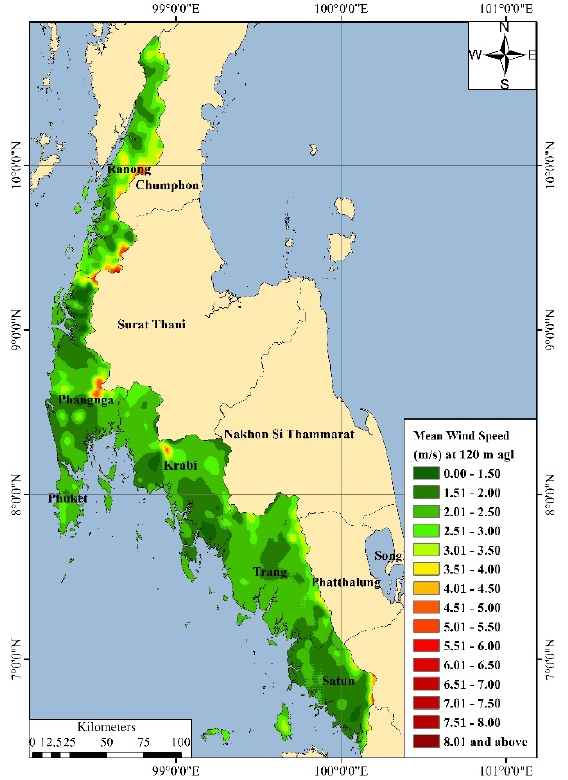
Figure 6. Microscale wind resource map at 120 m agl for the western coast of Southern Thailand.